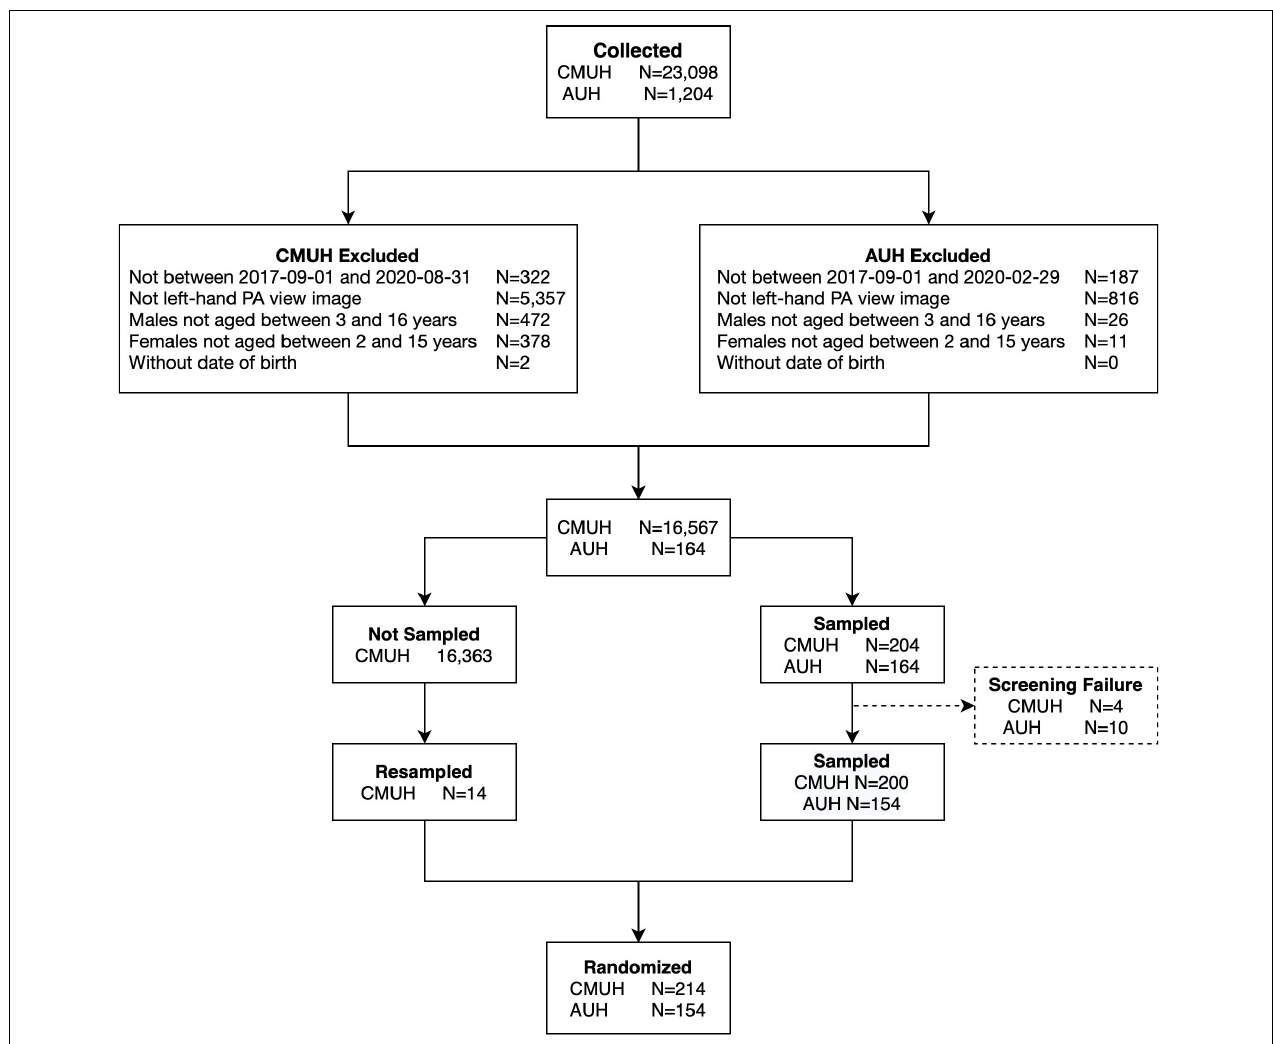
FIGURE 1 | Flowchart of radiographs enrolled in the